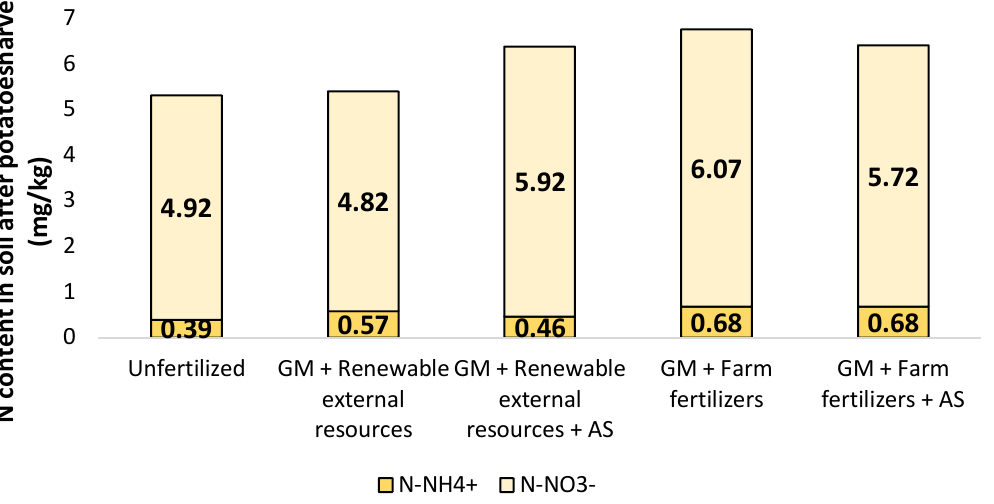
Figure 4. Content of mineral nitrogen in the soil after the harvest of potato tubers (observed treatments, 2016).